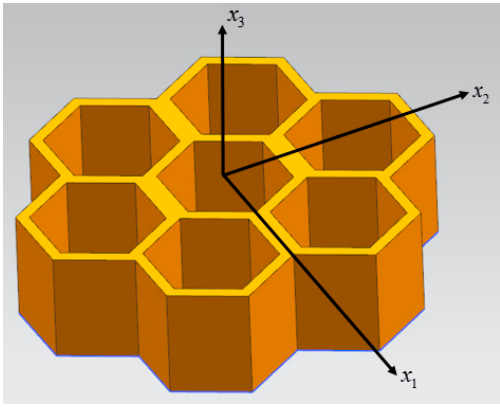
Figure 2. Coordinate system of aluminum honeycomb structure.